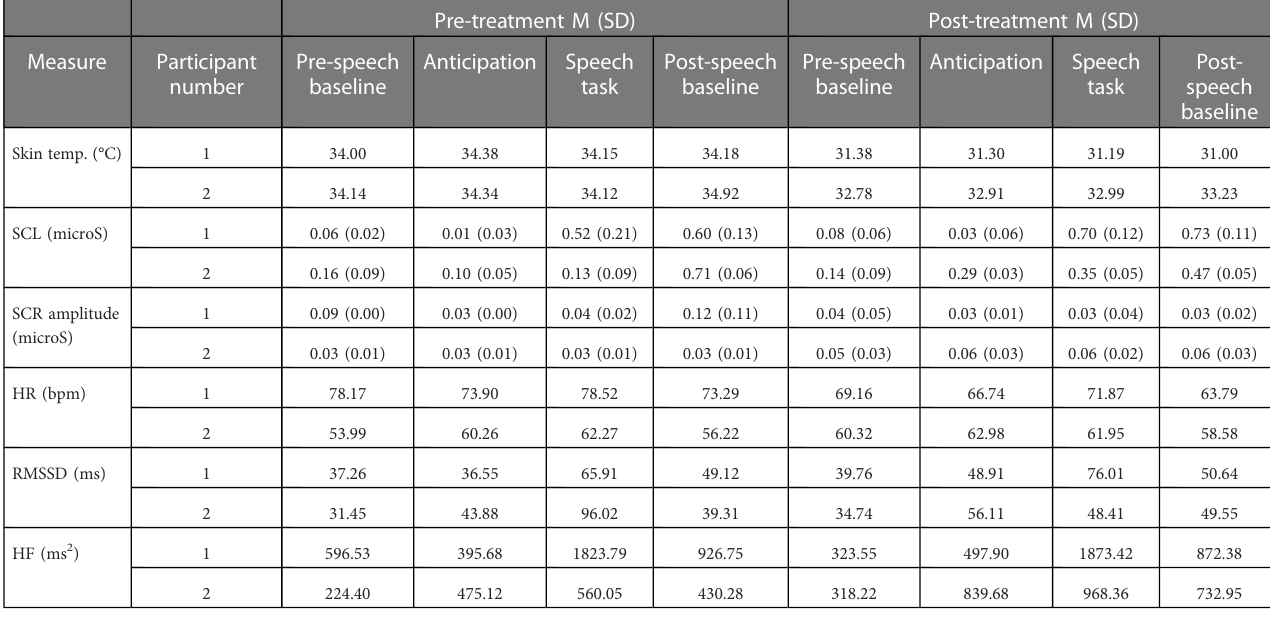
TABLE 3 Descriptive statistics for physiological